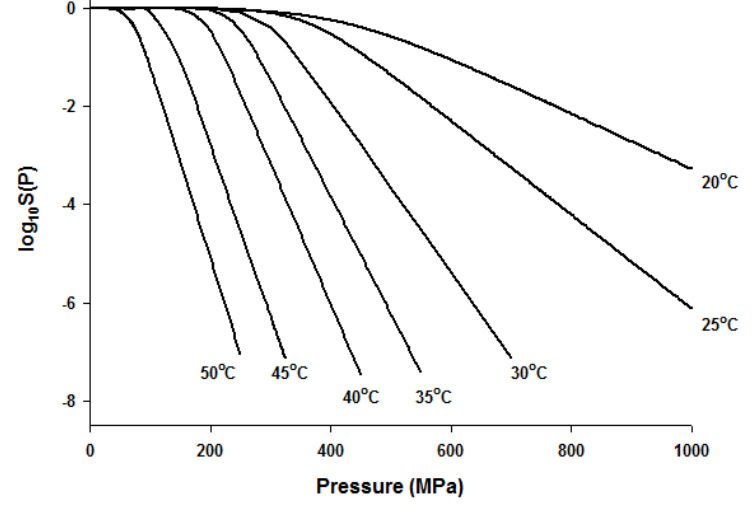
Figure 3. Simulated dose ‐ response curves with the Fermi equation for microbial inactivation by HHP at different temperatures.